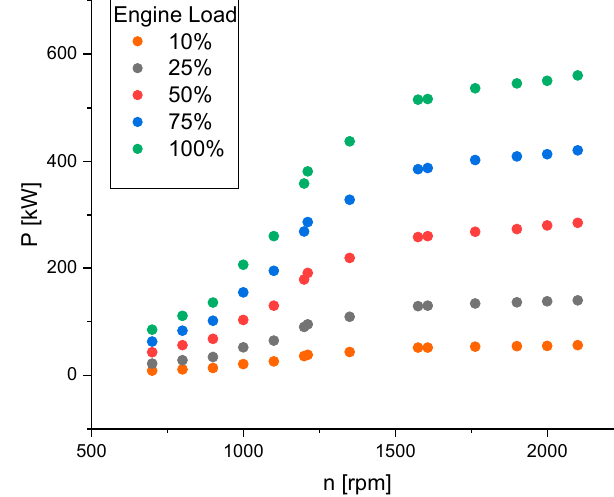
Figure 4. Speed-Power-Load [%] output map.